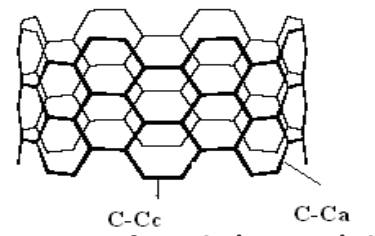
Fig.1: Structure of armchair CNT, indicating the two types of C-C bonds; C-Caxial (C-Ca) and C-Ccircumferential